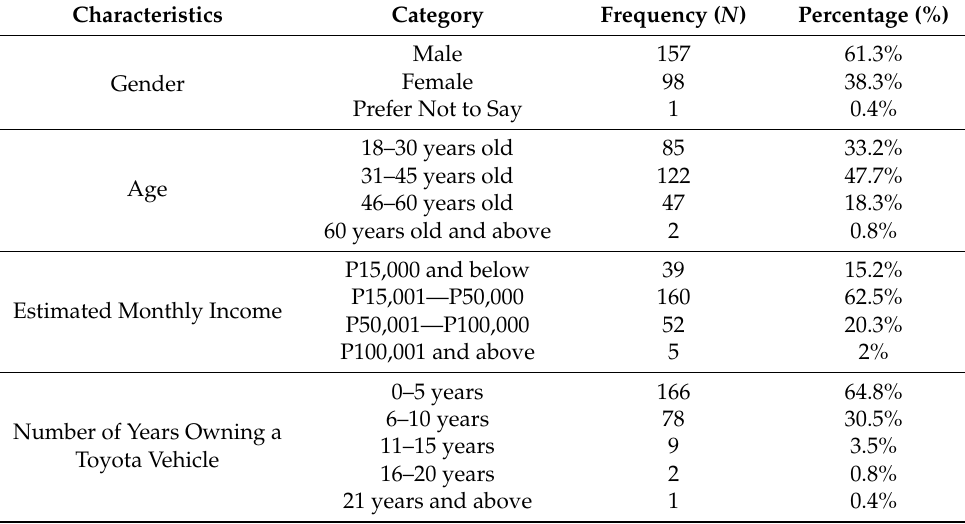
Table 1. Descriptive Statistics of Respondents ( N =